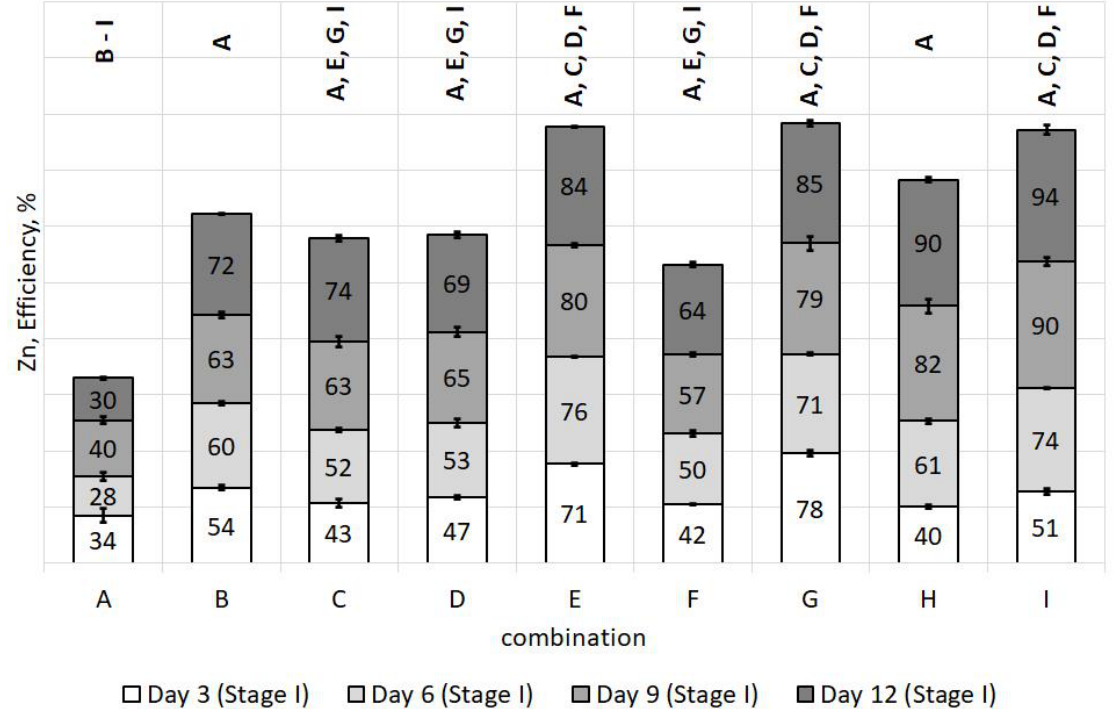
Figure 19. Effectiveness of Zn release to the dissolved fraction of leachate (Stage I).